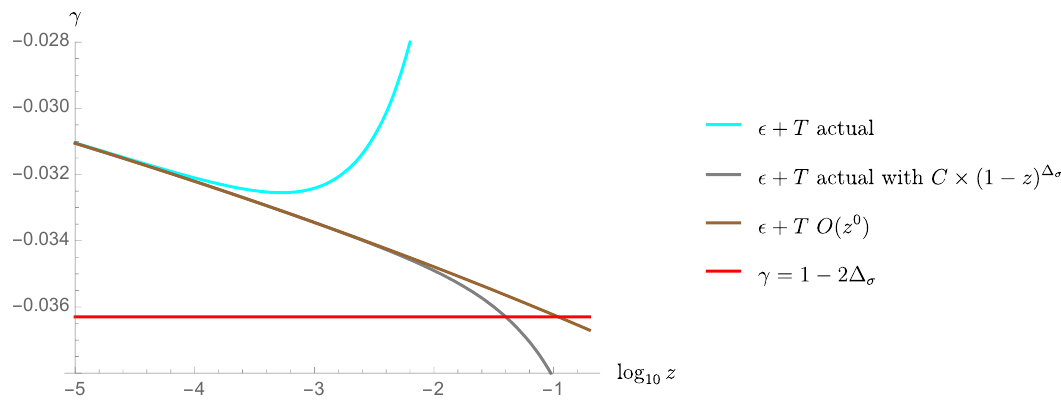
Figure 9 . Comparison between the twist derived by evaluating exactly individual blocks (using the 2d expansion) and their small- z limit. The agreement extends to larger values of z when the former is multiplied by (1 − z ) ∆ σ